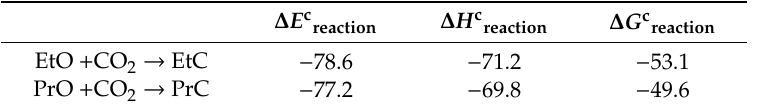
Table A2. Reaction energy, enthalpy and free Gibbs energy for CO 2 cycloaddition to EtO and